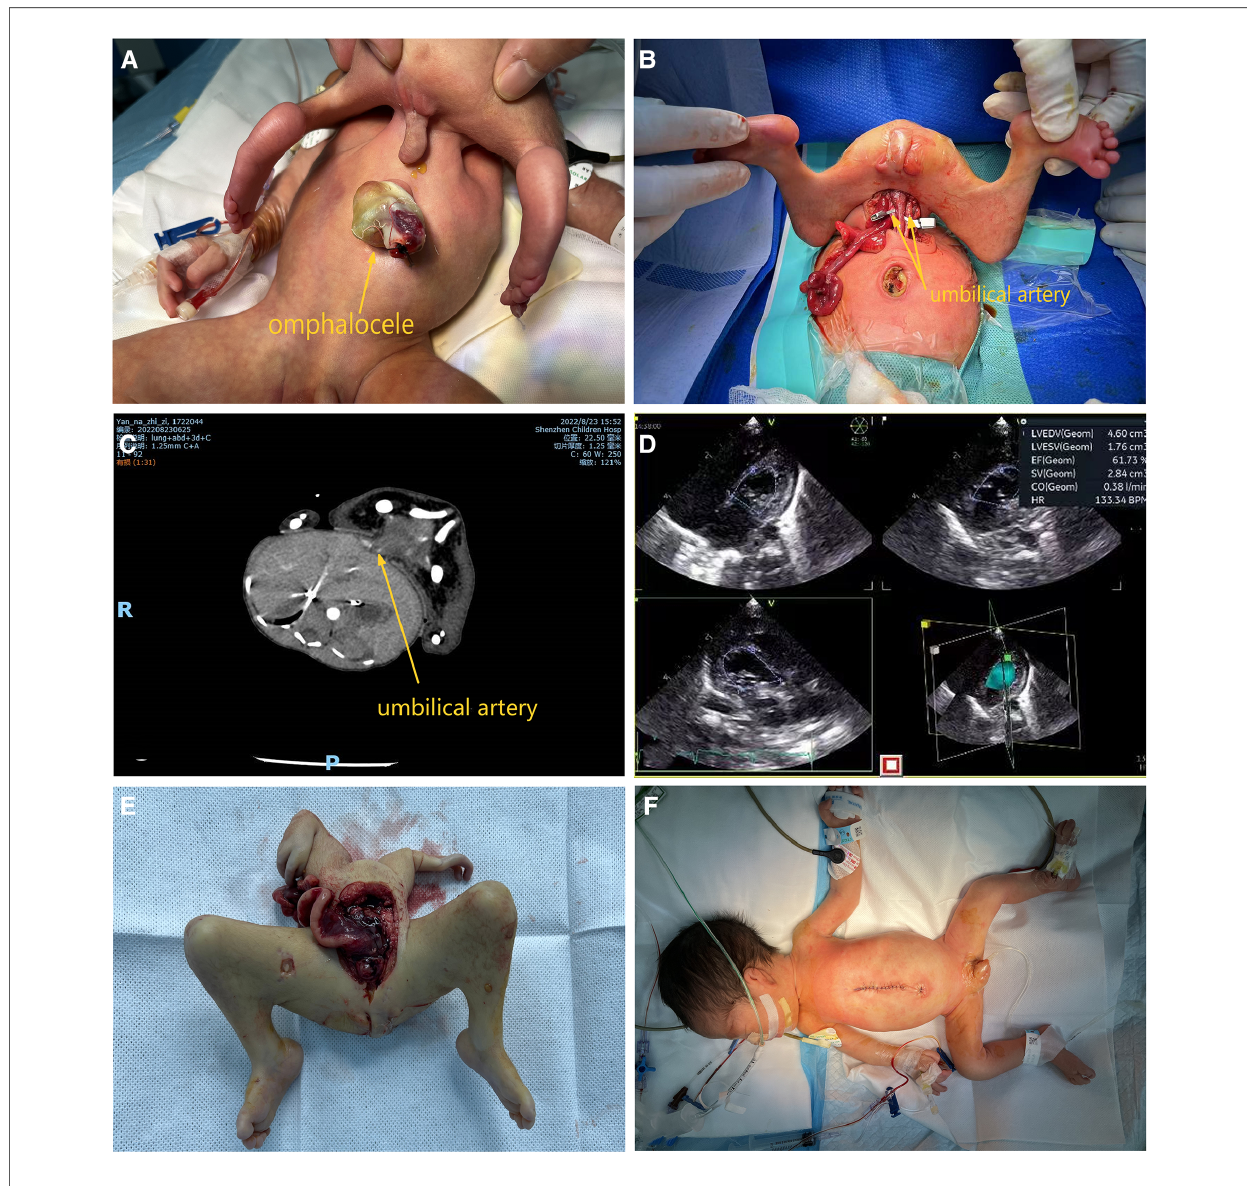
FIGURE 1 ( A – F ) Basic clinical datd of the